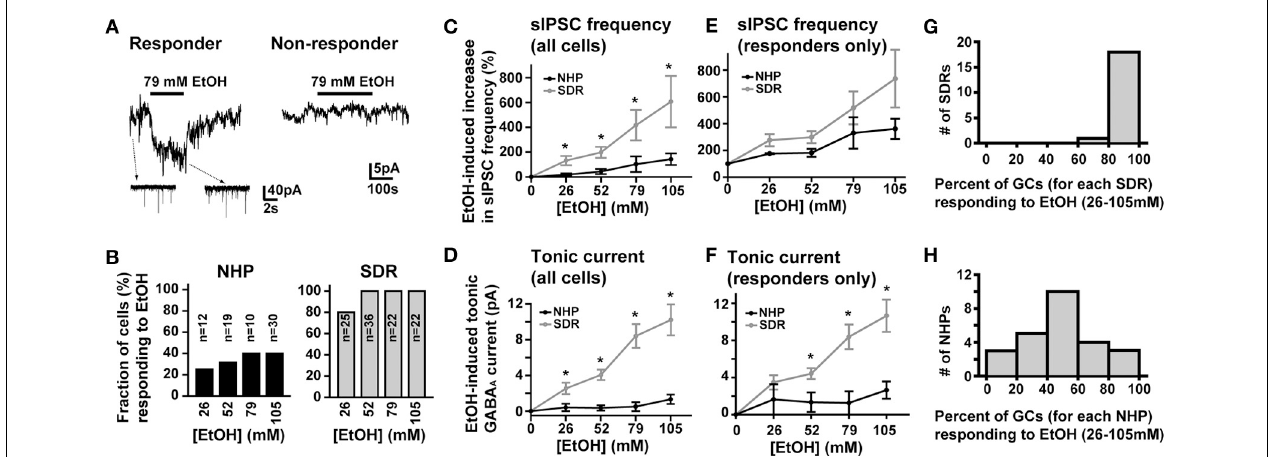
animals for each dose of EtOH, see panel (B) for details of proportion of responders and non-responders]. (D,F) Plot of the mean magnitude of the GC GABA A R tonic current induced by EtOH for all cells tested (D) or EtOH responding cells only (F) from SDRs (gray) and NHPs (black) [ ∗ indicates significantly different, P < 0 . 05, n = 21–35 GCs from 9–20 animals for each dose of EtOH, see panel (B) for details of proportion of responders and non-responders]. Note, in all responding cells examined, subsequent application of GABAzine (10 μ M) abolished all EtOH-induced currents. (G,H) Plot of the proportion of GCs from individual animals that responded to EtOH at any dose of EtOH tested. The distribution for SDRs and NHPs are plotted in (G) and (H) respectively.